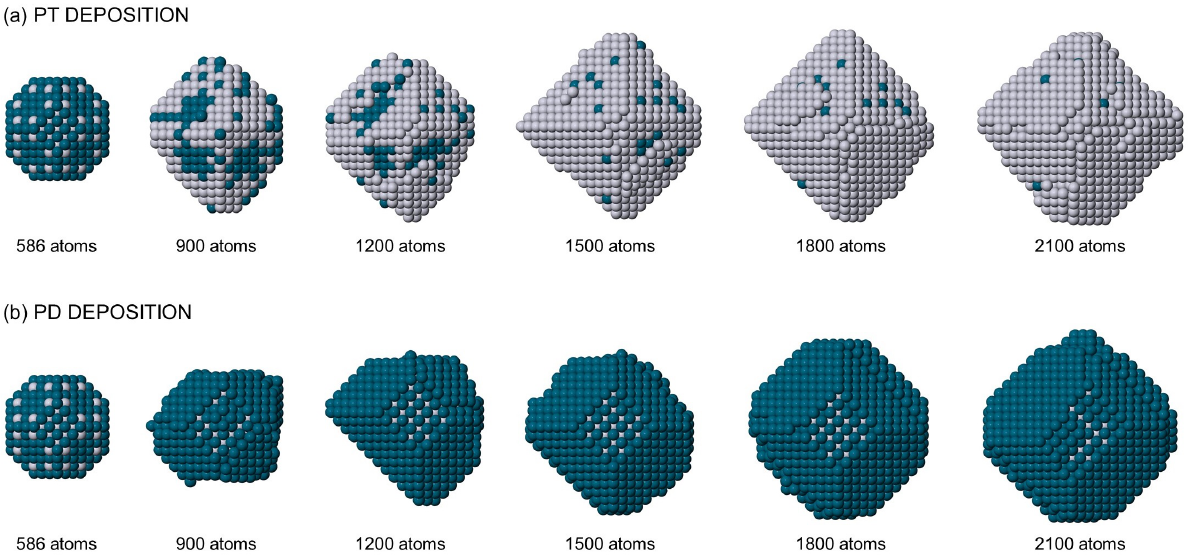
Figure 5. Growth sequences for ( a ) Pt and ( b ) Pd deposition. The simulations are run at 700 and 800 K,